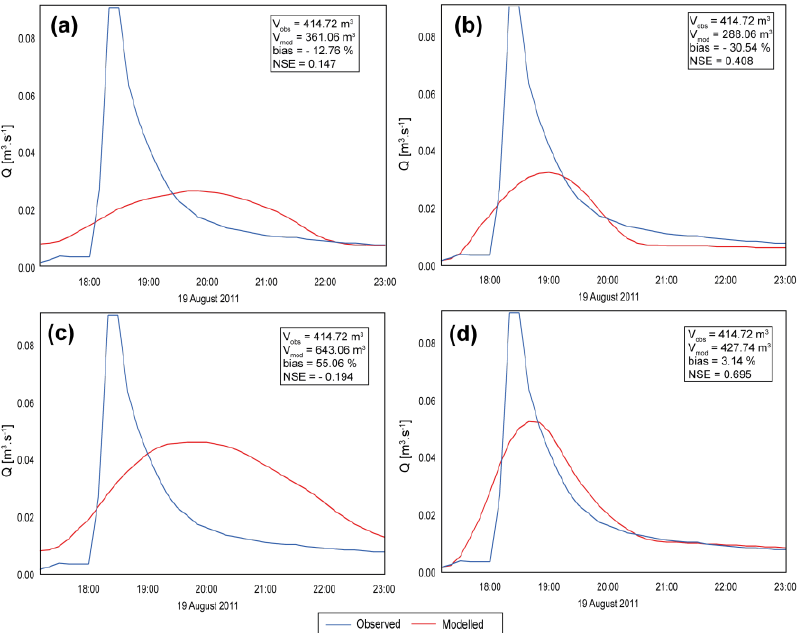
Figure 9. Verification of surface runoff simulations of a runoff event with a rapid onset in the NE catchment using the HEC-HMS software. The simulations were computed using original I a , CN and T c values corresponding to λ = 0.2 ( a ), modified I a , CN and T c values corresponding to λ = 0.2 ( b ), original I a , CN and T c values corresponding to λ = 0.0142 ( c ) and modified I a , CN and T c values corresponding to λ = 0.0142 ( d ) . The model’s performance is expressed by the bias of runoff heights and NSE coefficient.